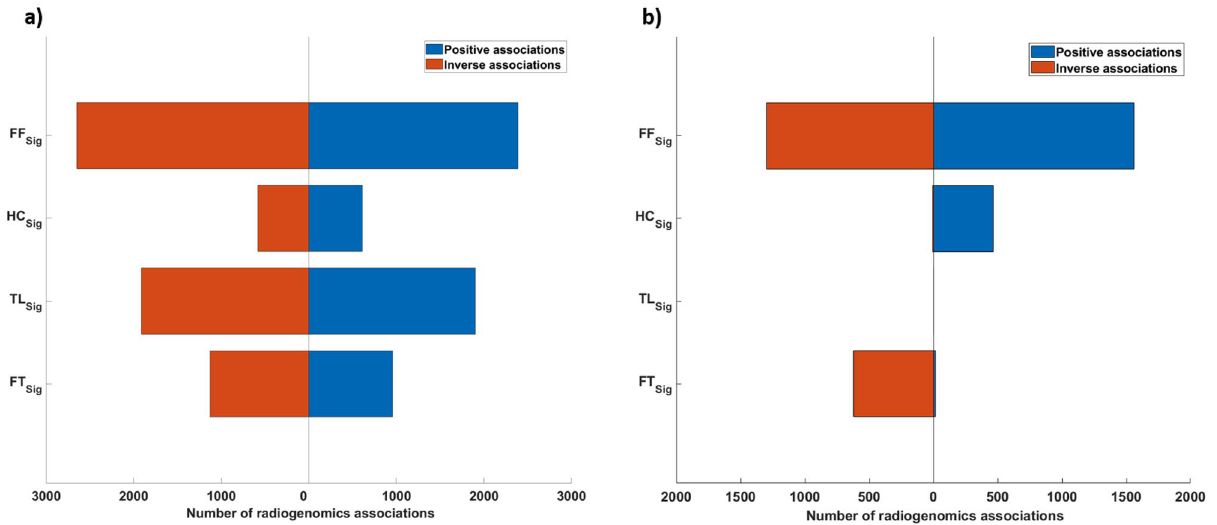
Figure 3. The distribution of RRs between feature signatures and: ( a ) gene expression value of the processed genes (n = 11,318) from the NRG-H dataset. ( b ) Gene expression value of the processed genes (n = 2993) from the NRG-S